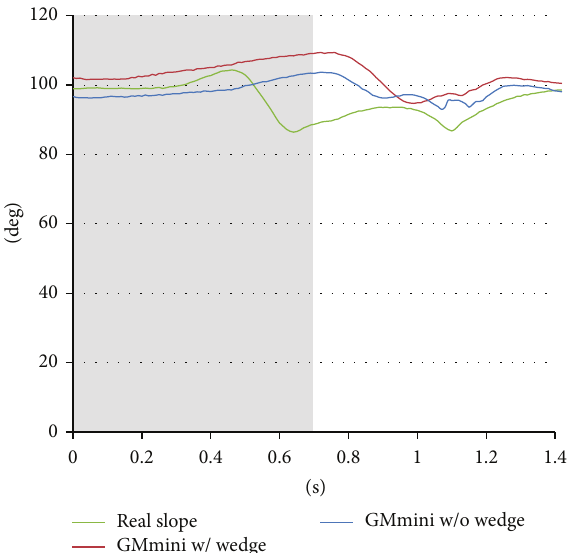
Figure 13: Time series variation of the average angle of the subjects’ ankle during ascent of a 5-degree incline.